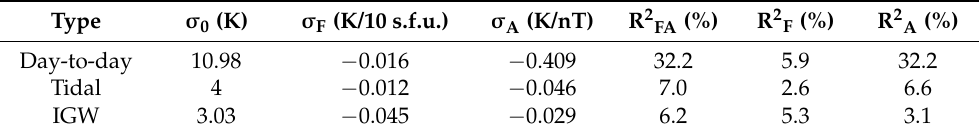
Table 2. Coefficients of multiple regression of σ Tm on F10.7 and Ap ( σ 0 , σ F , σ A ) and coefficients of determination for multiple (R 2 FA ) and simple regressions (R 2 F , R 2 A ).